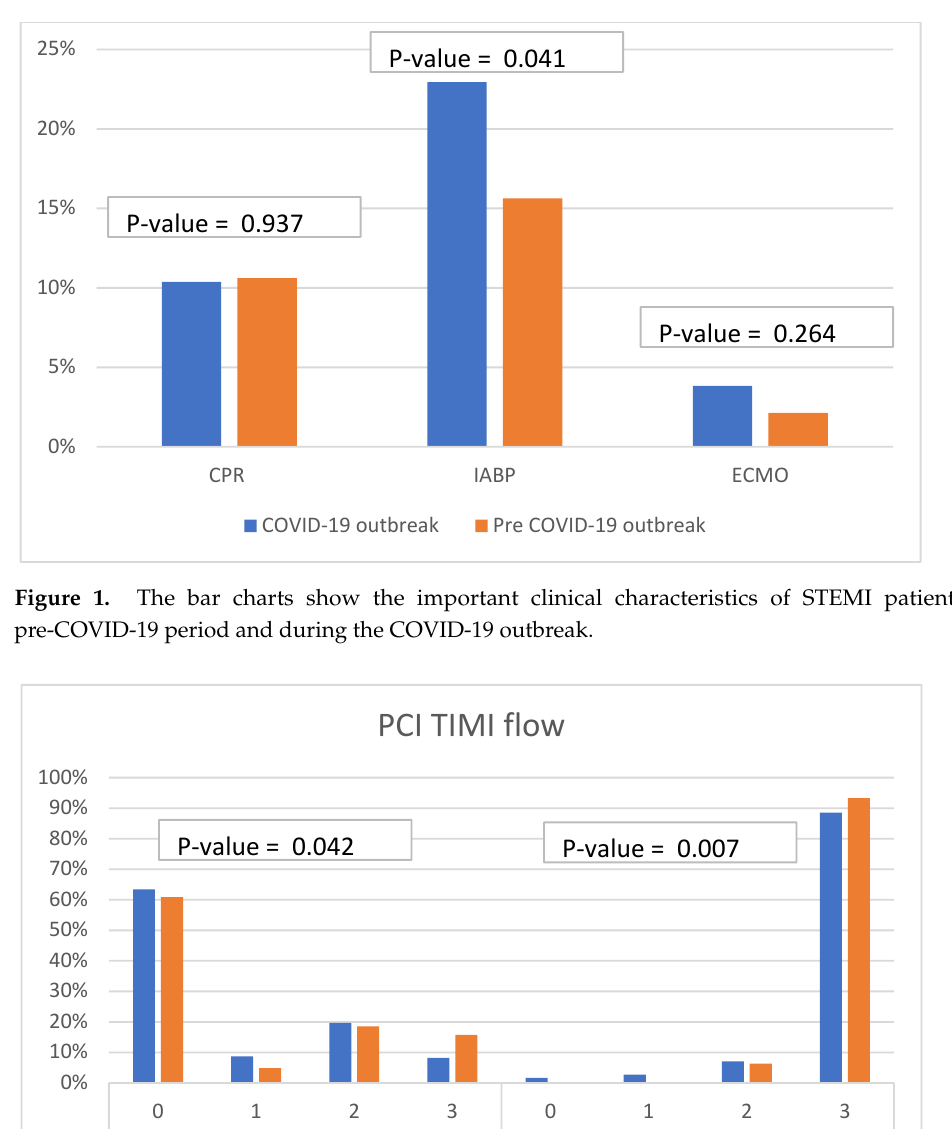
Figure 1. The bar charts show the important clinical characteristics of STEMI patients in pre-COVID- 19 period and during the COVID-19 outbreak.